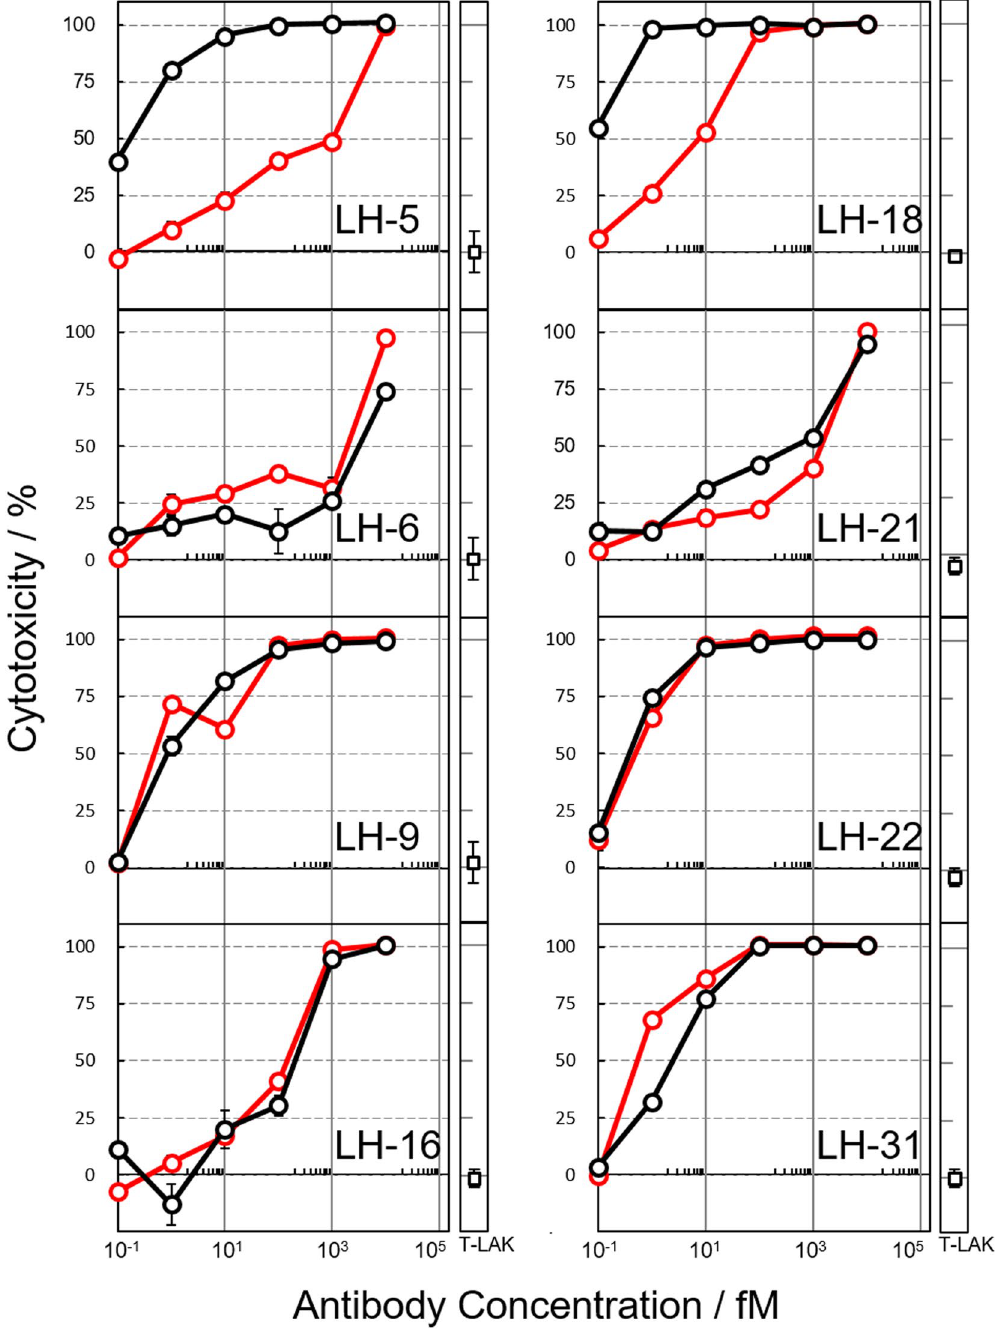
Figure 3. Comparison of cytotoxicity between IMAC-refined and SEC-purified diabodies. For each IMAC- refined diabody (black line) and SEC-purified diabody (red line) of LH-5, -6, -9, -16, -18, -21, -22, and -31, cytotoxicity against TFK-1 cells was measured. All the experiments were conducted three times. Data are represented as means ± S.E. In the horizontal axis, T-LAK indicates experiments without diabody but with T-LAK